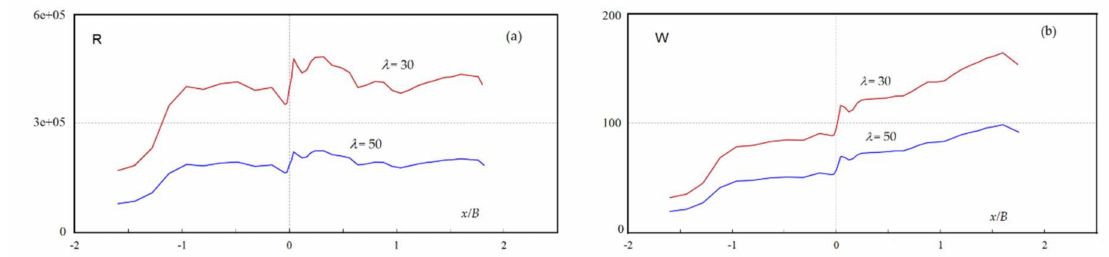
Figure 6. Bergeforsen spillway model; ( a ) R diagram for λ = 30, 50; ( b ) W diagram for λ = 30,